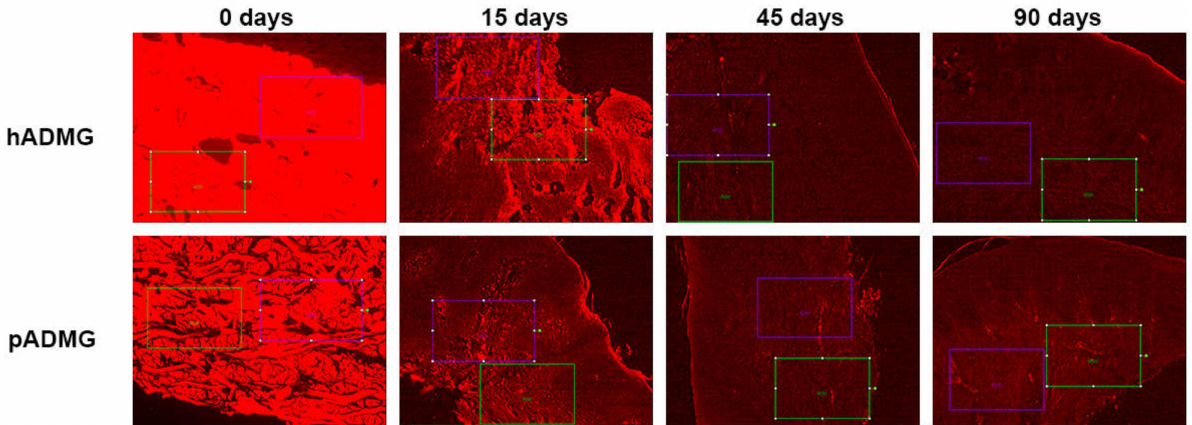
Figure 3. Fluorescence images at different times for the different ADMGs. Note the tracing of the analysis areas (100 × ).